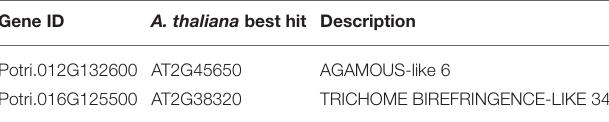
TABLE 1 | IDs, Arabidopsis thaliana best hits and corresponding descriptions of genes in the gentisic acid/cis-3-caffeoyl-quinate signature cluster ( Figure 12 ). Gene ID